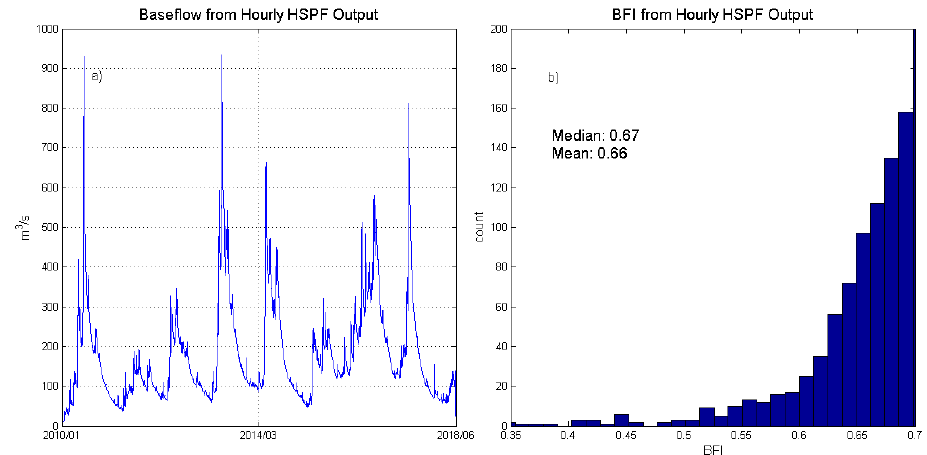
Figure 13. Baseflow extracted from daily averaged HSPF output, looping three times (blue) or five times (red) using the method introduced in [41]. When the loop number is set as 3, the separated baseflow still looks ragged, possibly contaminated by the “quick flow” (i.e., overland streamflow).